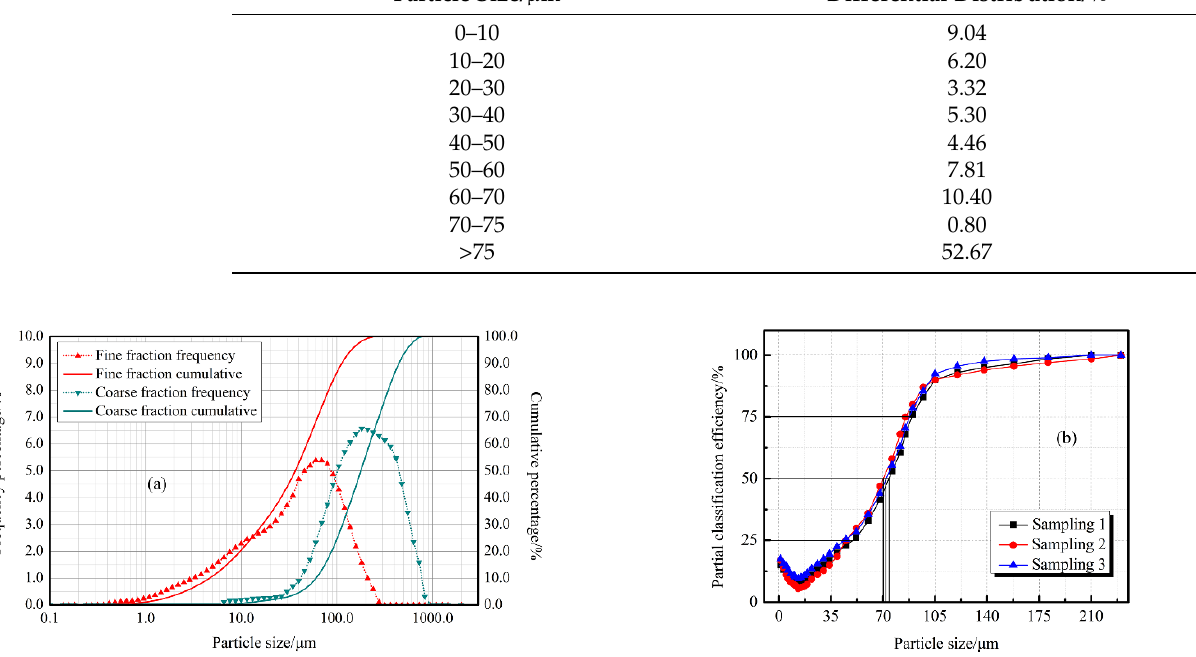
Figure 28. ( a ) The particle size distribution of the coarse and fine powders and ( b ) Tromp curves for the industrial classifier.